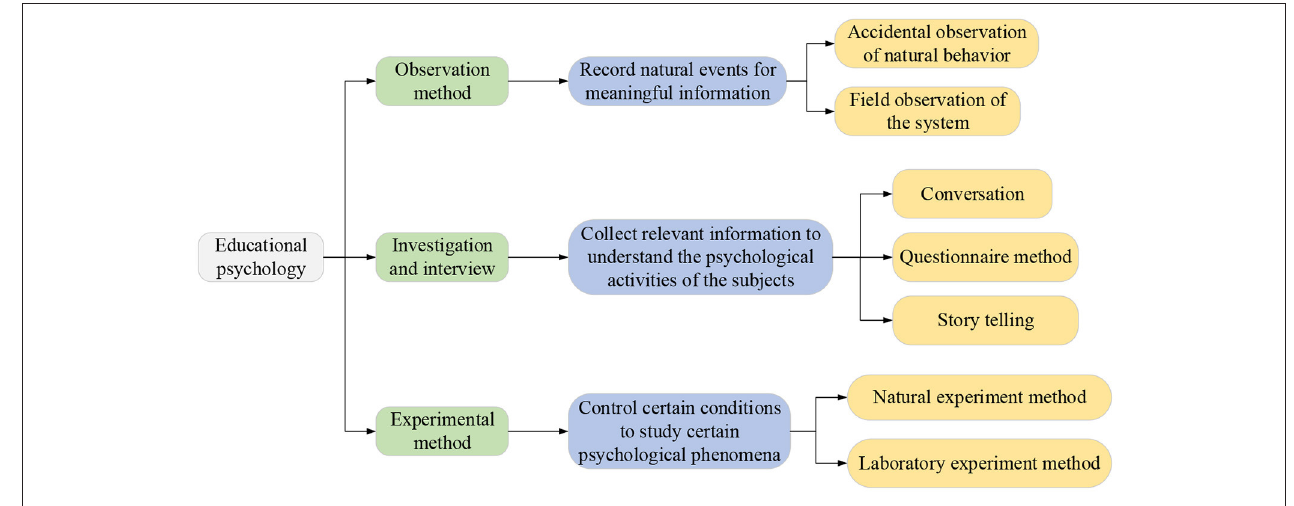
FIGURE 1 | Research methods of educational